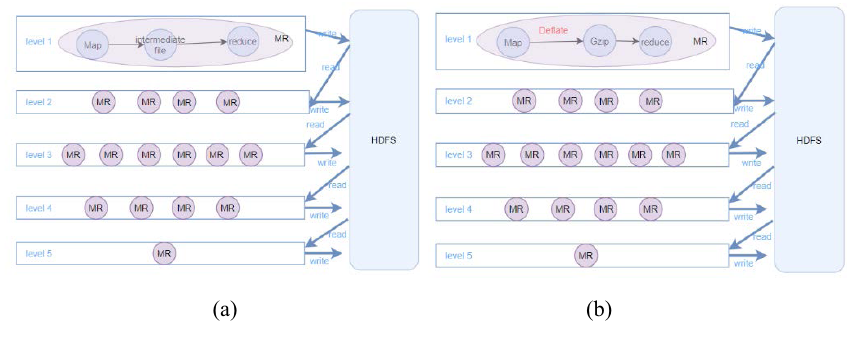
Fig. 3. Traditional Cubing and Accelerated Cubing.